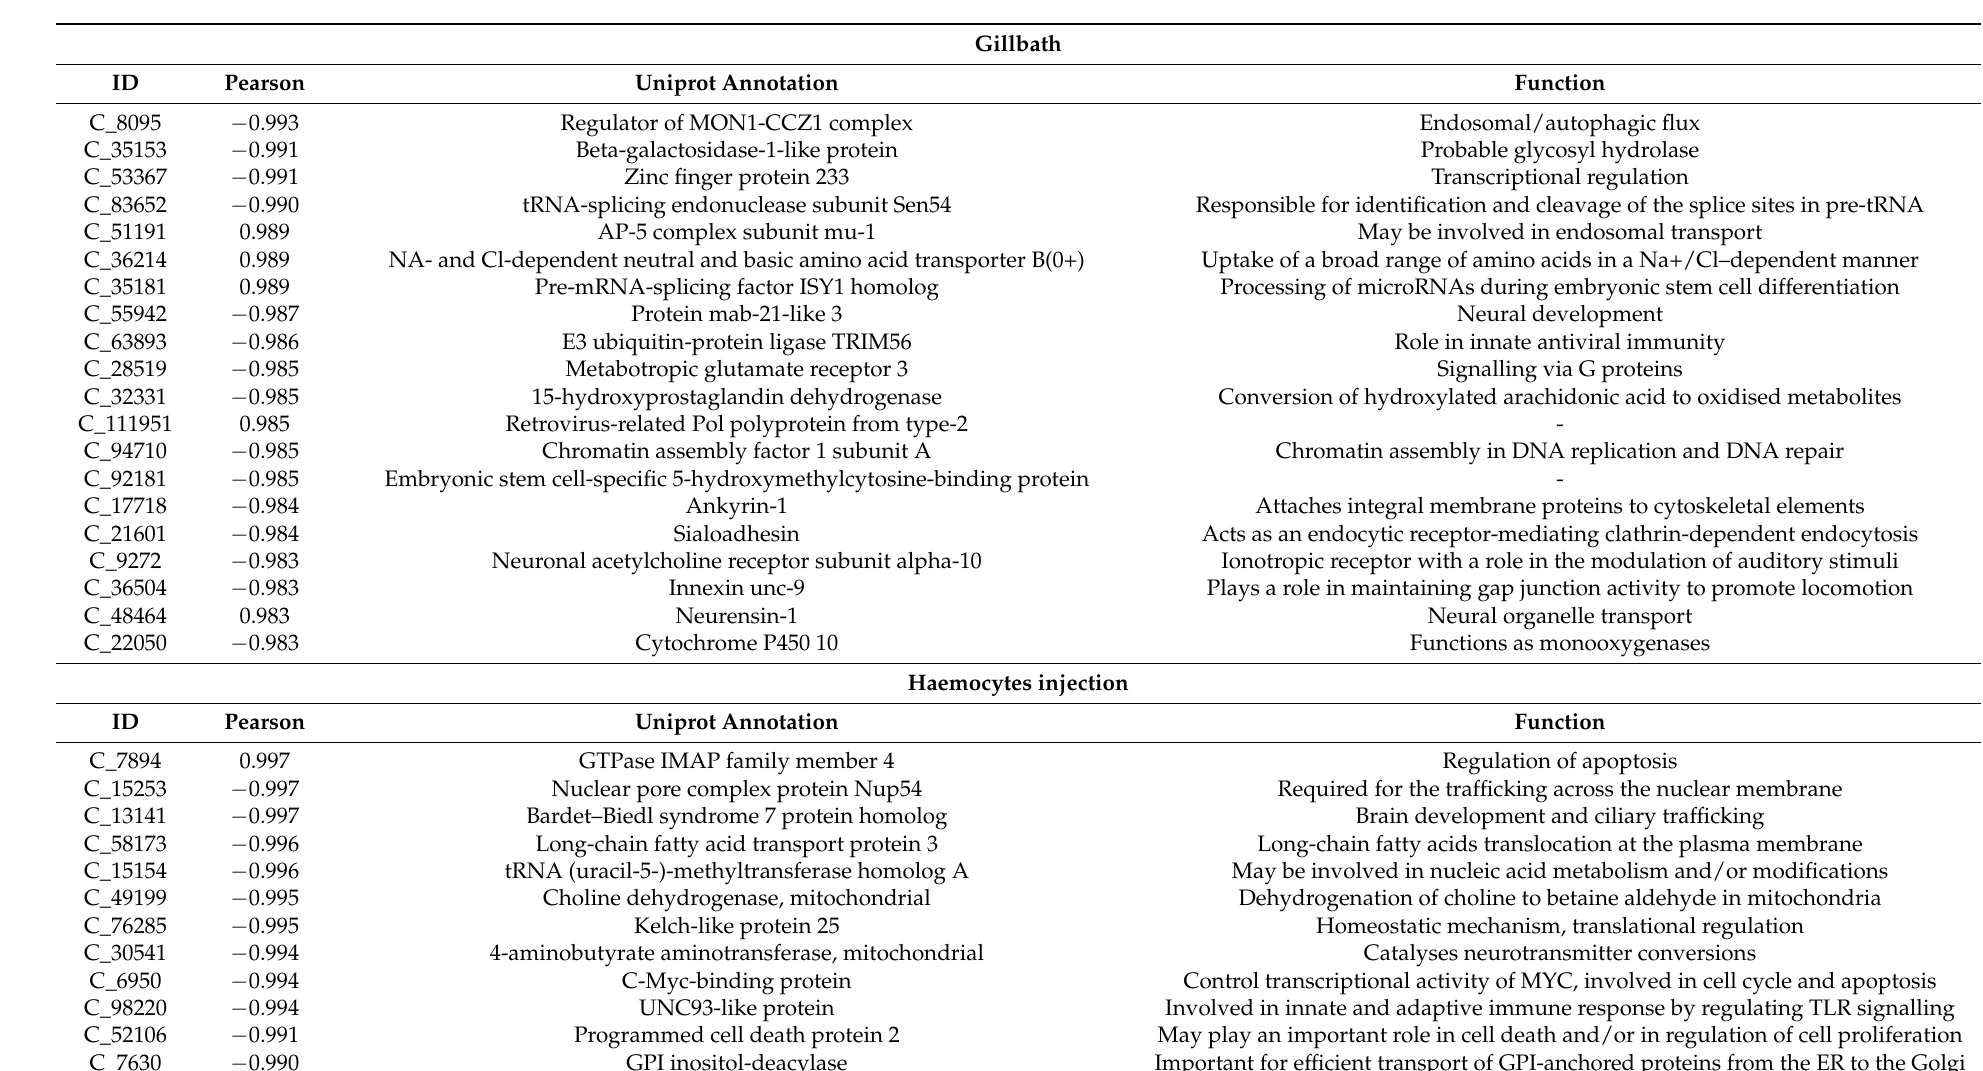
Table 2. Genes correlated with Vibrionales abundance data. Pearson column shows the correlation